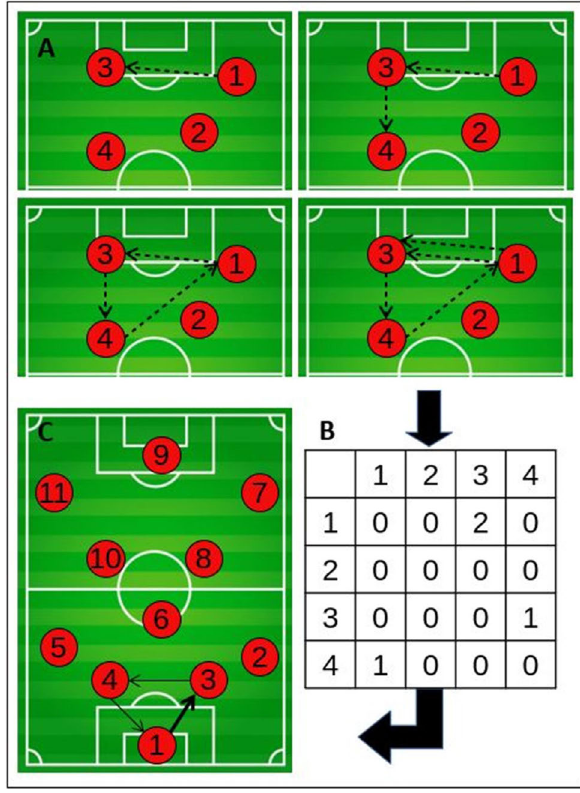
Figure 1 - Process the data collecting: an observation of the real passing sequence; b converting the observation for the corresponding adjacency matrix; c converting for the weighted digraph. Adapted from Clemente et al